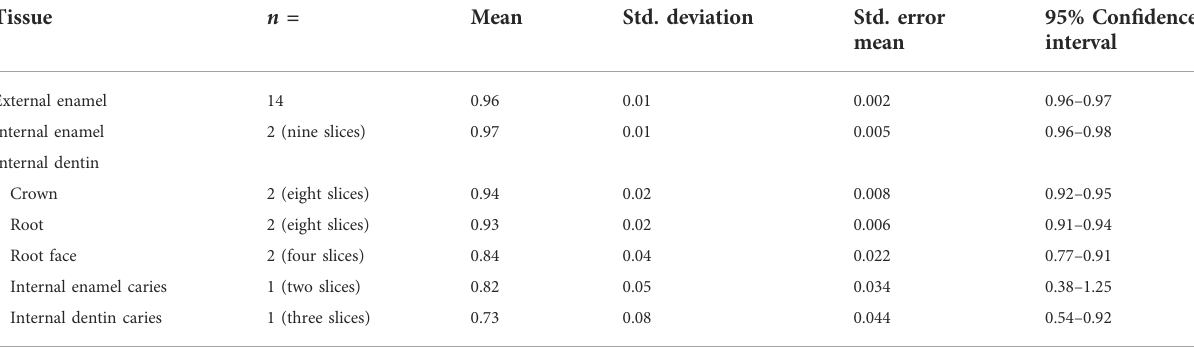
TABLE 5 Descriptive statistics for emissivity values of sound external enamel, internal enamel, dentin, root-face dentin, and caries-affected internal enamel and dentin.